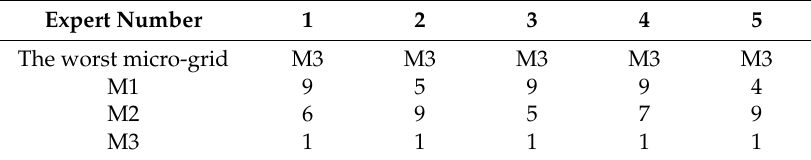
Table 5. Compared results of other micro-grid planning programs over the worst